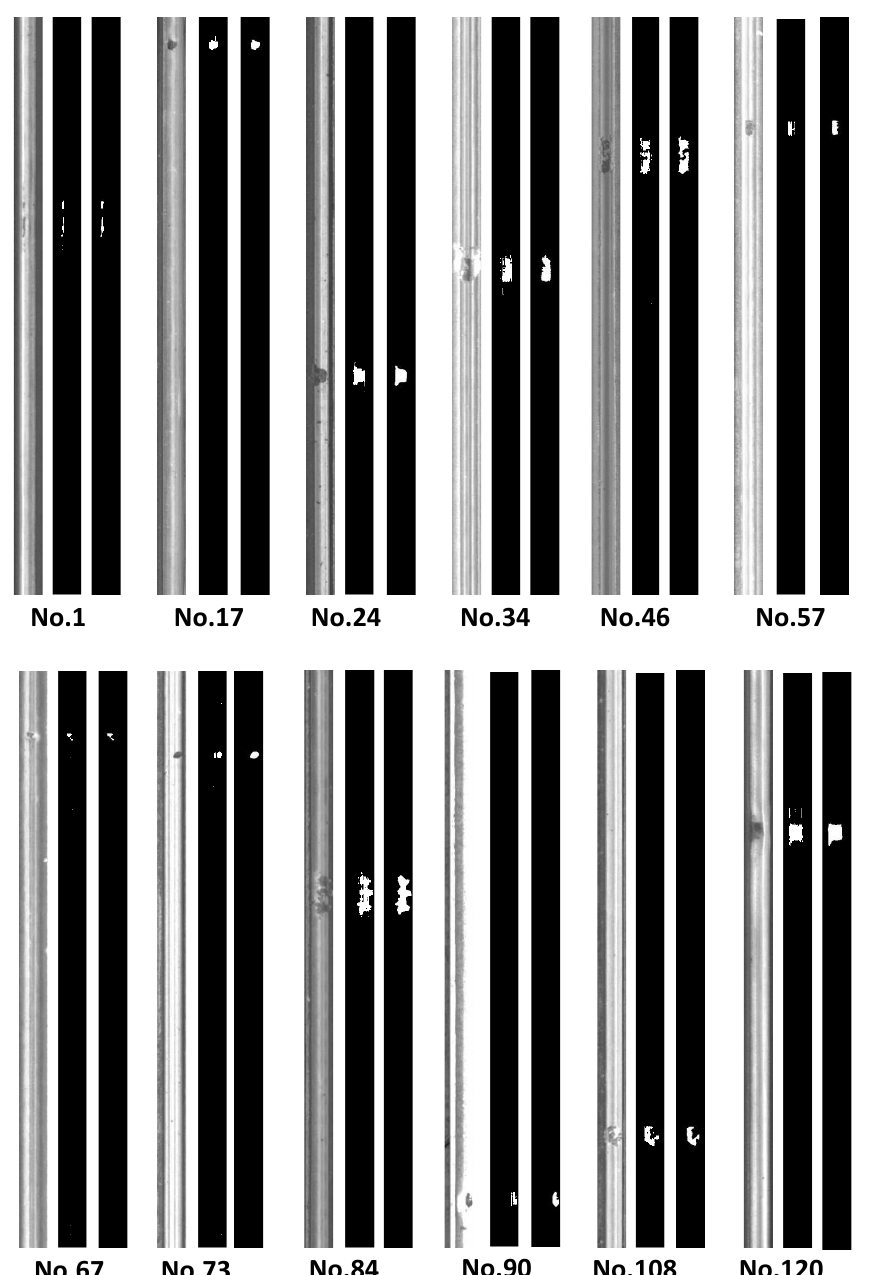
Figure 6. Example rails in the validation set, with labels Nos. 1, 17, 24, 34, 46, 57, 67, 73, 84, 90, 108, and 120 in the Type-II RSDD dataset. The sequence of each rail images is the original image, the learning result, and the ground